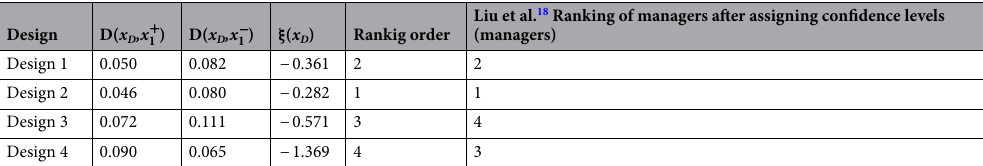
Table 12. PFTOPSIS calculation results for the conceptual design solution.